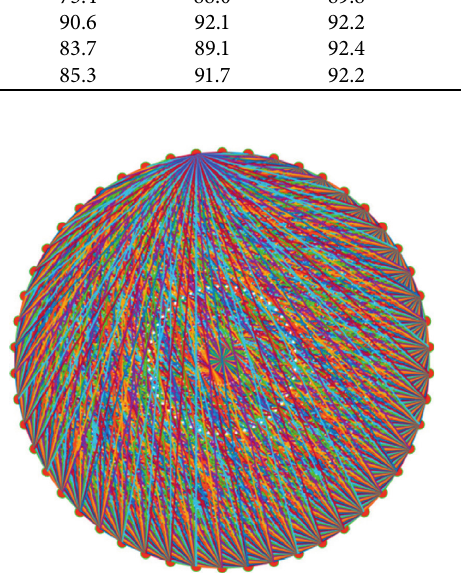
Figure 16: Fully connected